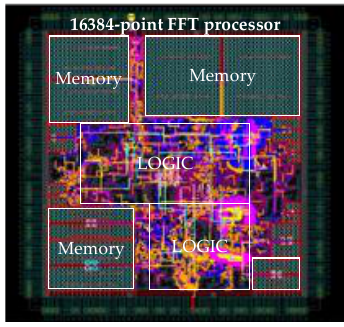
Figure 10. Layout of 16,384 point, 16-bit pipeline FFT processor. Table 8. Specifications of the FFT co-processor chip.